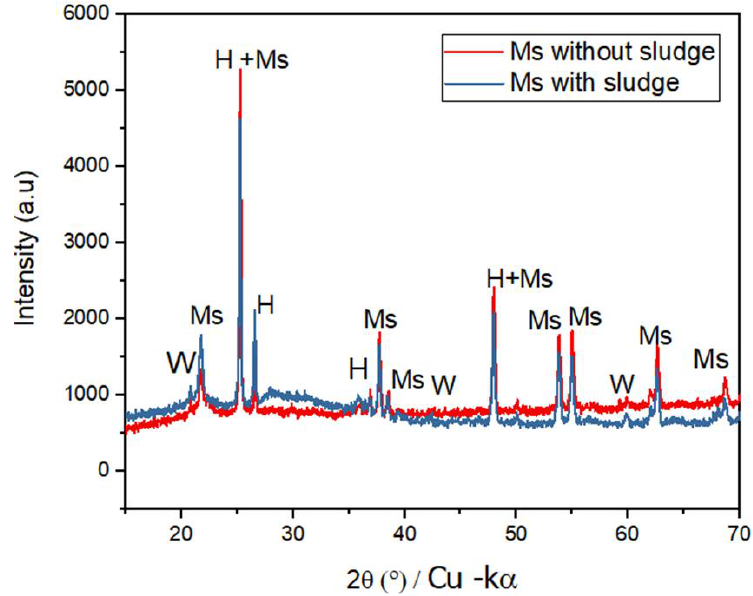
Figure 2. X-ray diffraction iron oxides (Ms) profile with and without sludge corresponding to JCPDS file No. 19-0629 reference line patterns; Ms magnetite (Fe 3 O 4 ), H : hematite (α-Fe 2 O 3 ) and W : wustite (FeO).